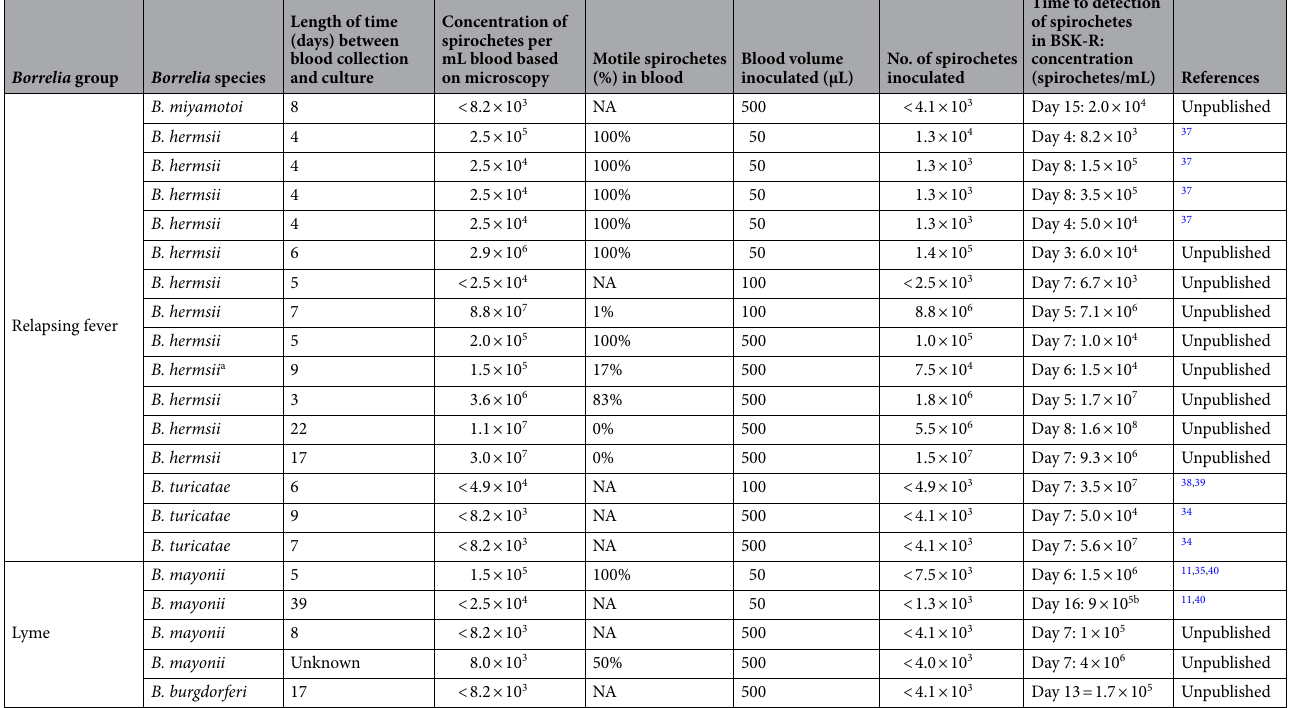
Table 3. Primary culture recovery of Lyme and relapsing fever Borrelia species in BSK-R. a Blood draw 2 days post azythromycin treatment. b Blind passaged after 8